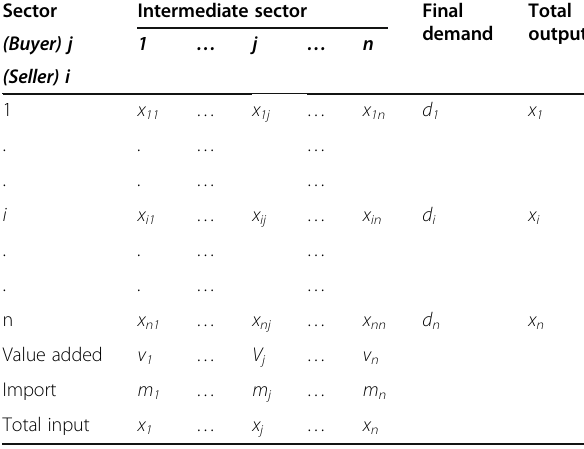
Table 1 Schematic representation of a conventional I – O table Sector Intermediate sector Final